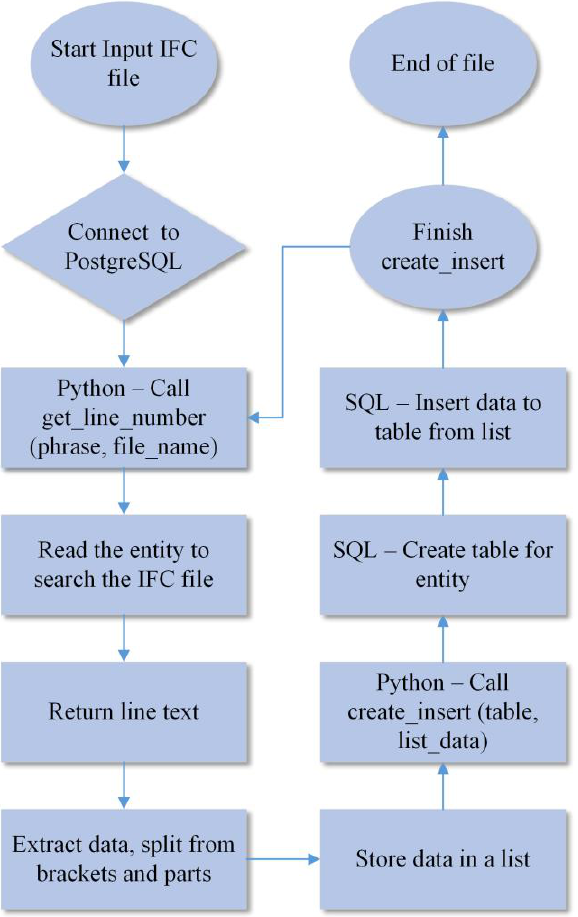
Figure 9: Diagram that shows the store method of IFC data in PostgreSQL